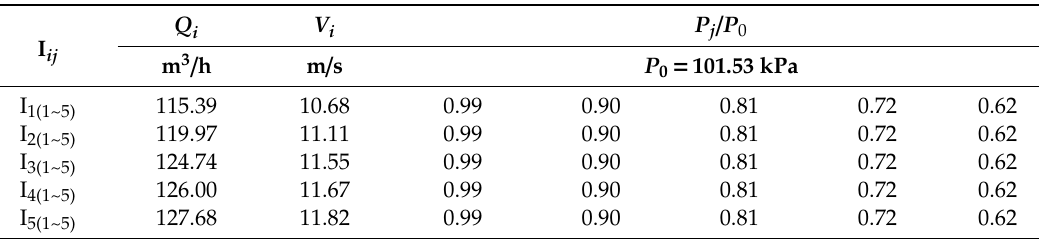
Table 2. Operating conditions parameters of